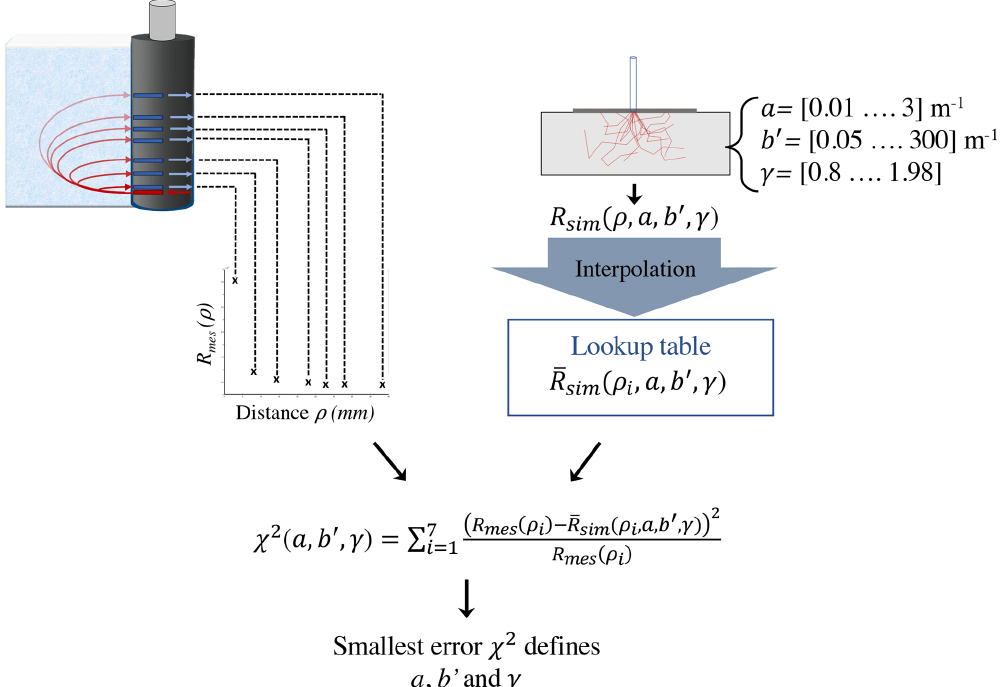
Figure 4. Illustration of the inversion algorithm used to retrieve inherent optical properties of sea